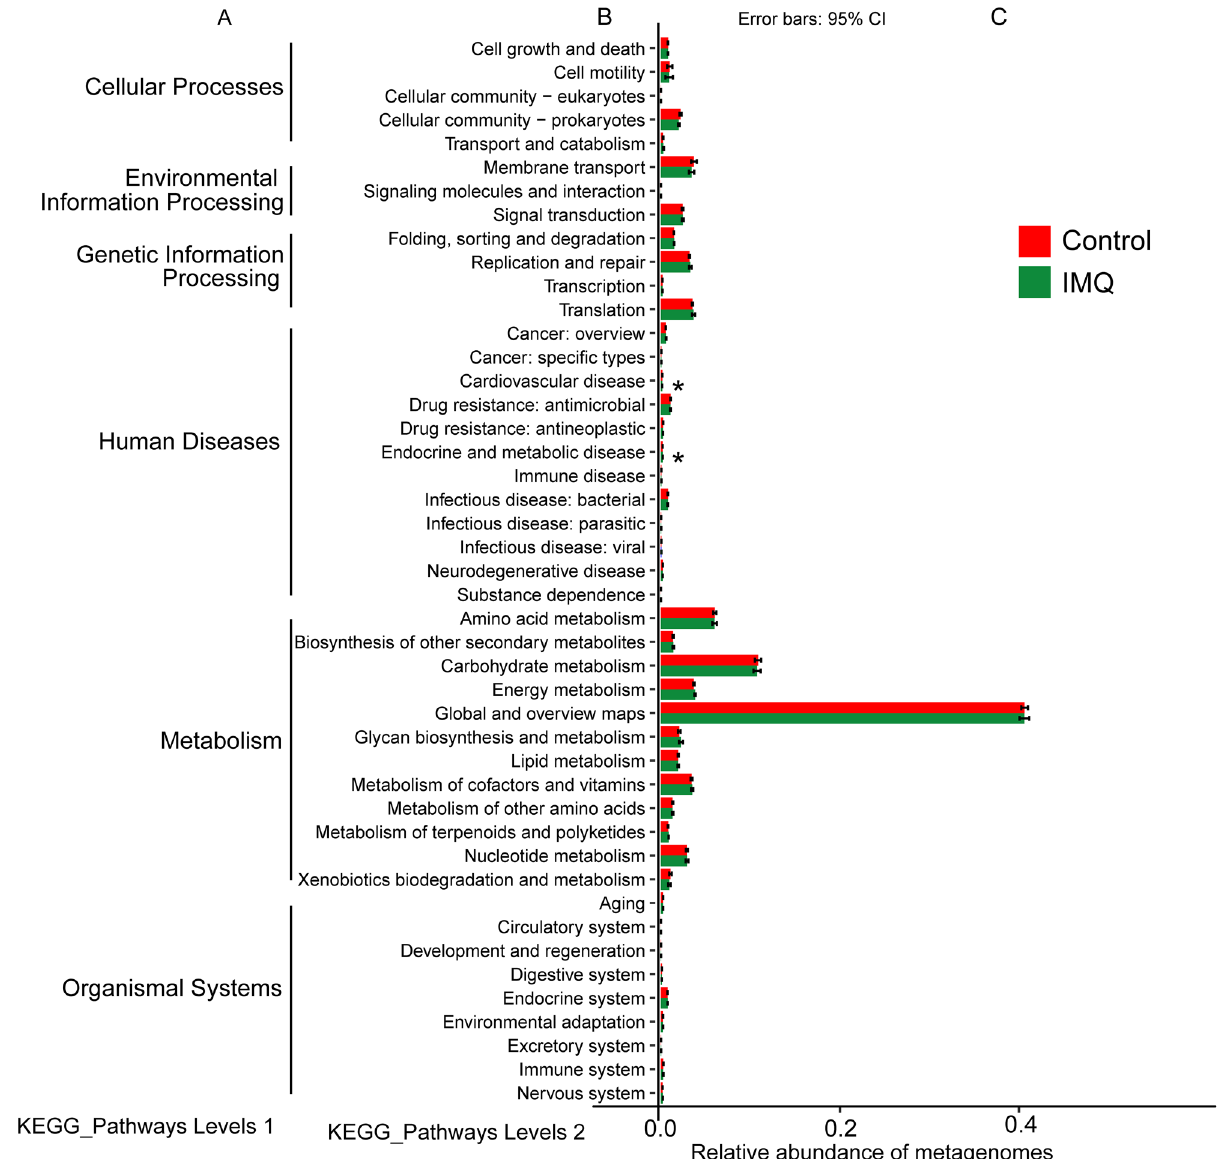
Figure 6. Relative abundance of KEGG pathways of functional categories in the gut microbiota. Functional predictions of the gut microbiota between the control group and IMQ group. Significant differences of KEGG pathways at level 2 were detected using STAMP software based on the KEGG pathway database (www. kegg. jp/ kegg1. html). * P <